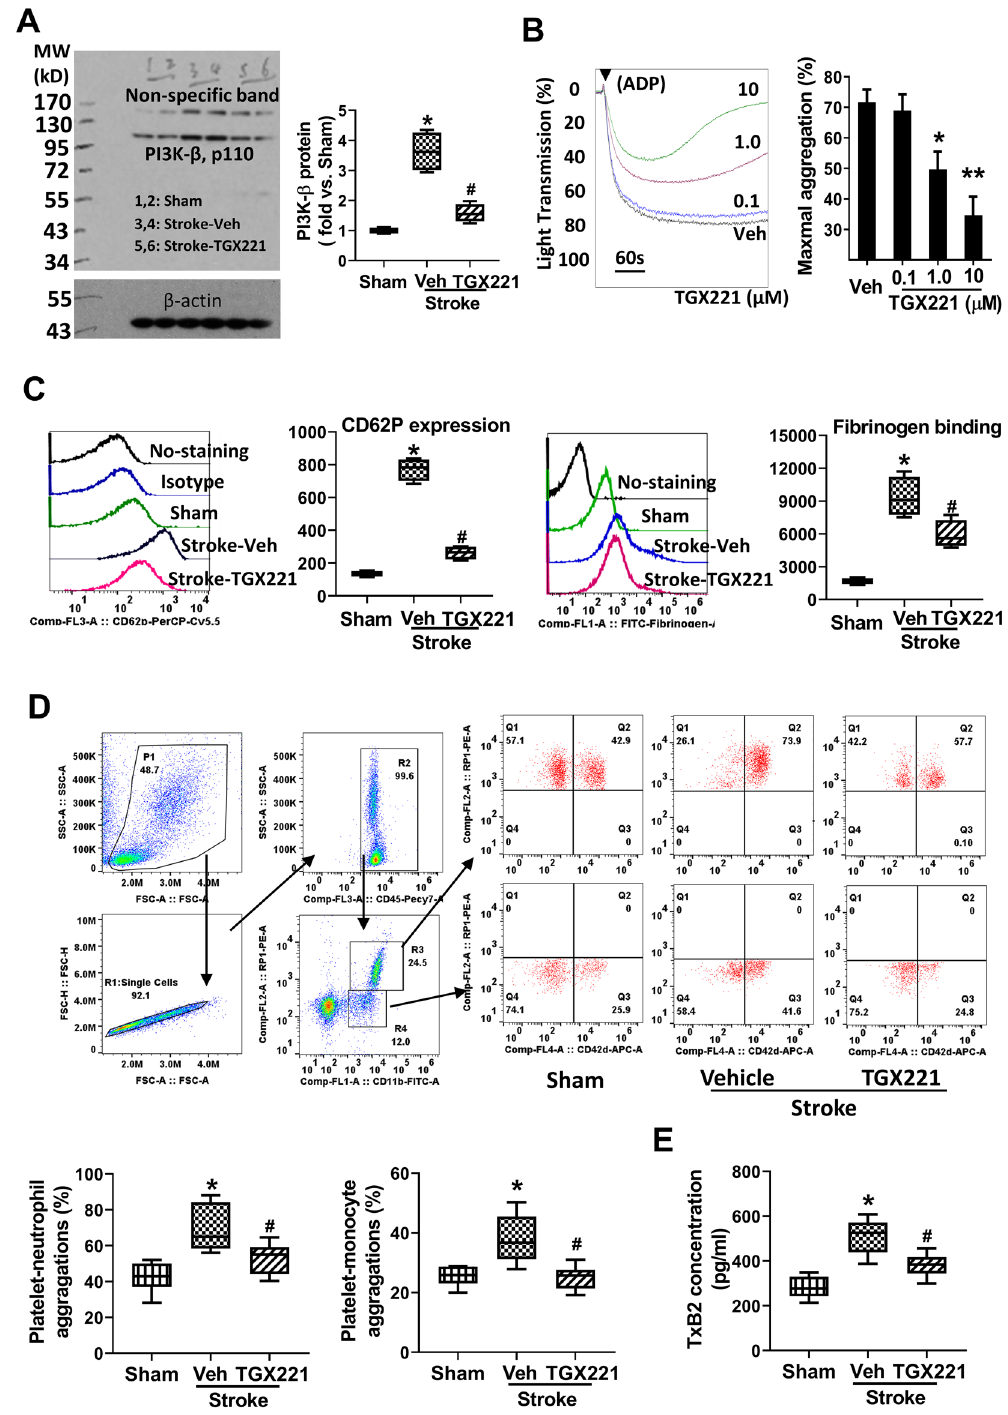
Figure 3. TGX221 treatment attenuates stroke-enhanced thrombotic response. ( A ) Representative images of western blots showing PI3Kβ protein levels in the platelets and semi-quantitative analysis of immunoblots. n = 4/group. *p < 0.05 vs. sham; #p < 0.05 vs. vehicle. Platelets were collected at 24 h after stroke. ( B ) Representative aggregation traces. Citrated PRP from normal rats were preincubated with different doses of TGX221 or vehicle for 30 min and then stimulated with 10 µmol/L ADP. Quantitative results are expressed as mean ± SD of three independent experiments. *p < 0.05 vs. Veh or 0.1 µm TGX221; **p < 0.01 vs. Veh or 0.1 µm TGX221. ( C ) Flow cytometry analysis of PerCP-Cy5.5-CD62p expression on platelets or FITC-Fibrinogen binding to platelets. Data are expressed as mean fluorescence intensity. n = 5/group. *p < 0.05 vs. sham; #p < 0.05 vs. vehicle. ( D ) Gating strategy for flow cytometric analysis of total leukocytes (R2, CD45 positive cells included in R1 single cells) in whole blood: neutrophils (R3) and monocytes (R4) were defined by their differential expression of CD11b and RP-1 (specific for rat granulocytes); and representative flow cytometric dot plots of platelet-neutrophil (CD42d + CD45 + CD11b + PR1 +) and –monocyte (CD42d + CD45 + CD11b + PR1−) aggregates in the indicated groups. APC-labeled CD42d (glycoprotein V) mAb was used as a specific platelet marker to identify platelet neutrophil/ monocyte complexes. n = 5/group. *p < 0.05 vs. sham; # p < 0.05 vs. vehicle. ( E ) ELISA assay of TXB2 concentration in plasma 24 h after stroke. N = 5/group. *p < 0.05 vs. sham; # p < 0.05 vs.